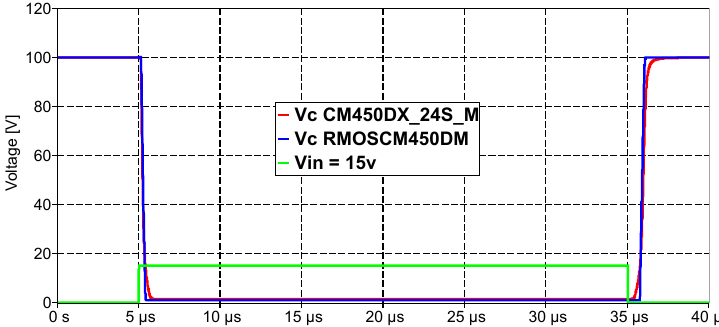
Figure 21. Rise and Fall time with R1 = R2 = 1 Ohm (Figure 19).